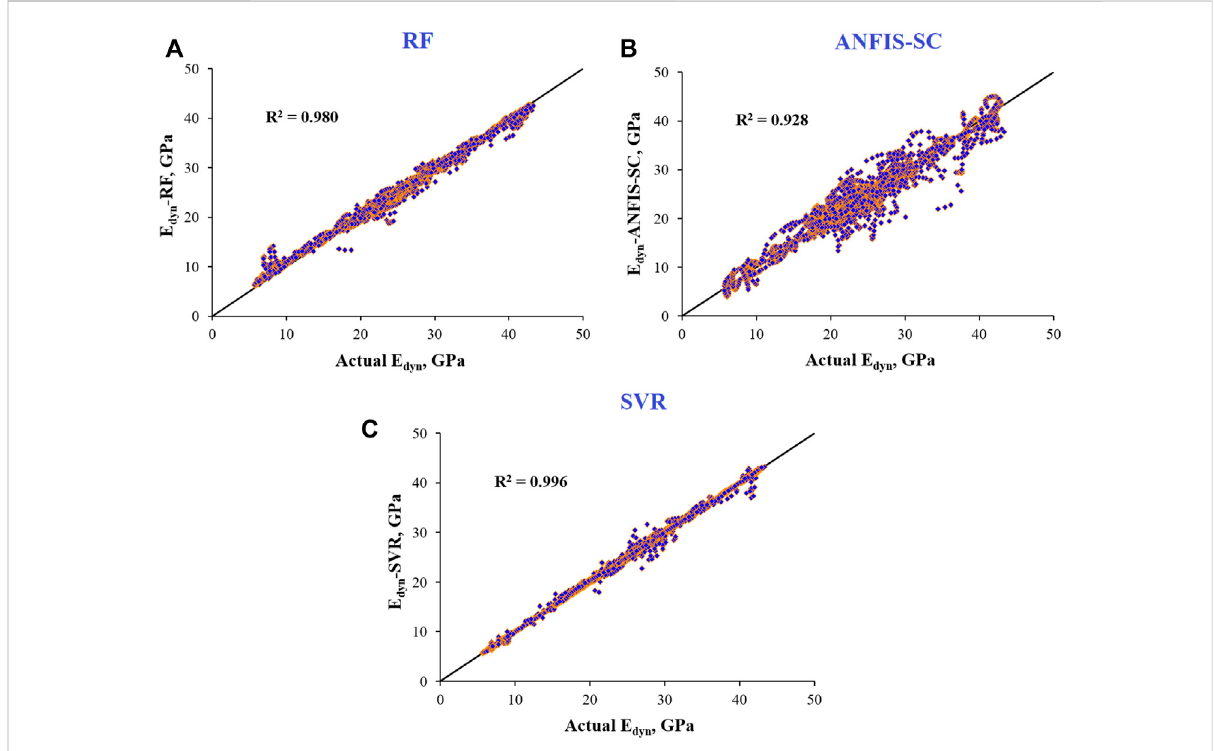
FIGURE 8 Cross-plots of the actual and assessed E dyn by the optimized (A) RF, (B) ANFIS-SC, and (C) SVR models for the 2912 validation data points of Well-C.